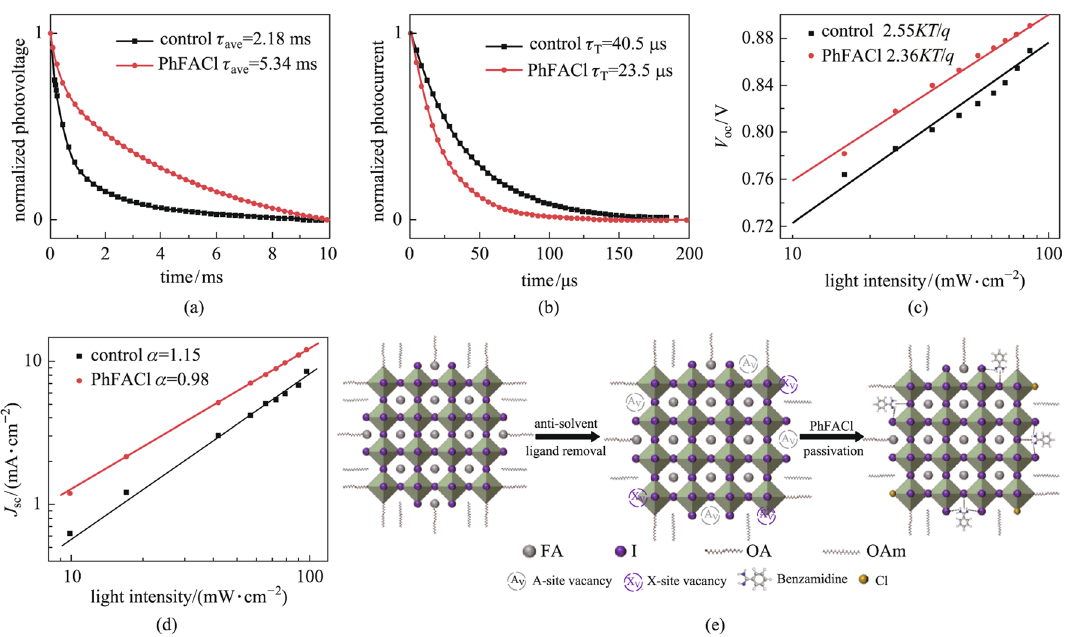
Fig. 5 Charge carrier dynamics of PQDSCs. a TPV and b TPC curves of control and PhFACl-based PQDSCs. c V PhFACl-based PQDSCs as a function of incident light intensity. e Schematic diagram of the passivation of the PQD surfaces using